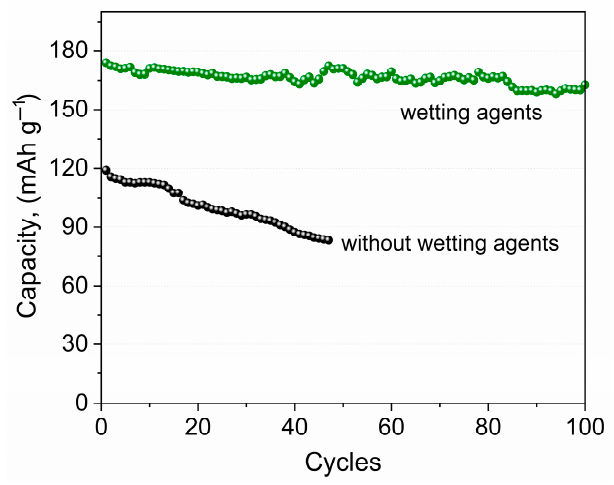
Figure 4. Dependence of the discharge capacity on the cycle number for the Li//LiFePO 4 cells, NPE with liquid electrolyte 1 M LiTFSI DOL/DME (1:1) (green line) and without it (black line) at the C/10 current rate in a voltage range of 2.6–3.8 V.